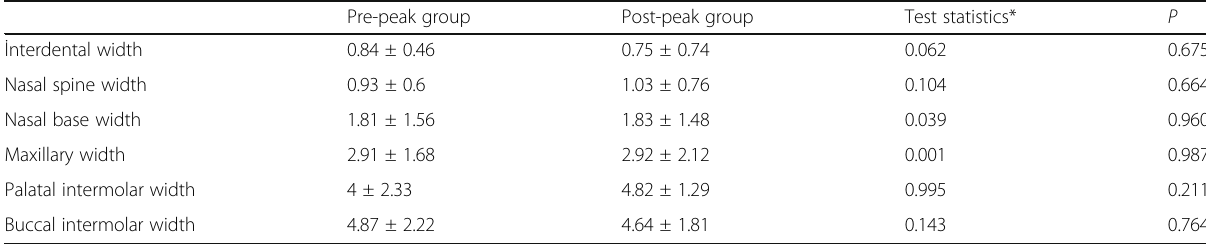
Table 4 Intergroup differences of each parameters Pre-peak group Post-peak